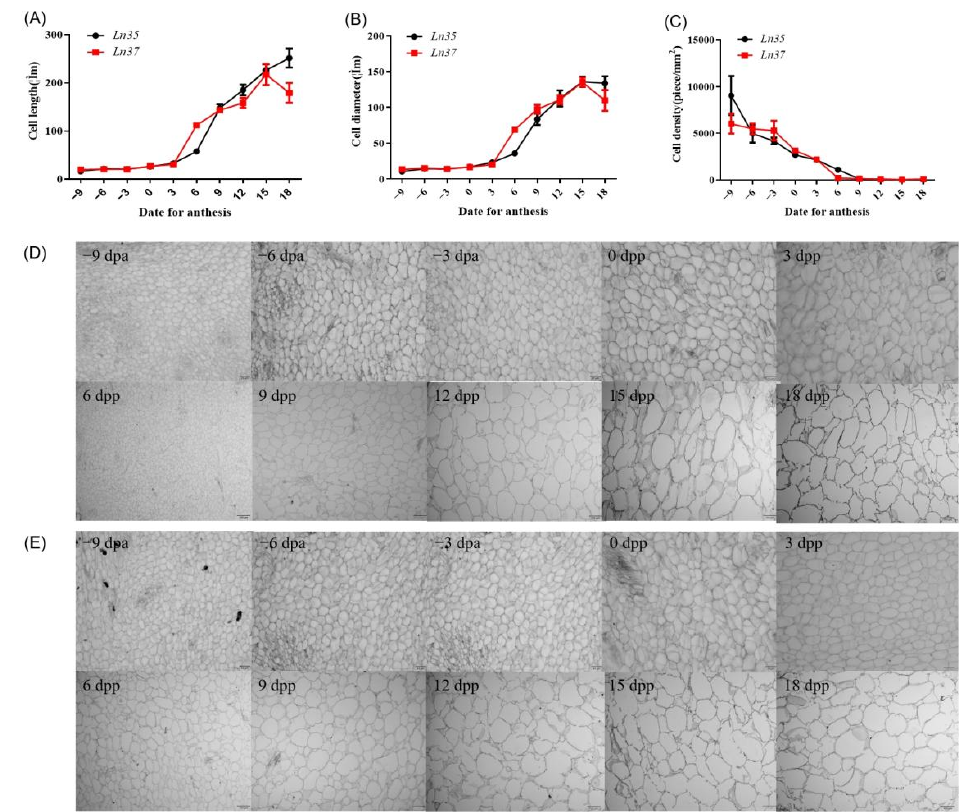
Figure 3. Fruit mesocarp cells shape in NILs. ( A – C ) are the changes in cell length, cell diameter, and cell density in NILs, respectively. ( D ) is the dynamic cellular changes of fruit cells in Ln35 , ( E ) is the dynamic cellular changes of fruit cells in Ln37 .